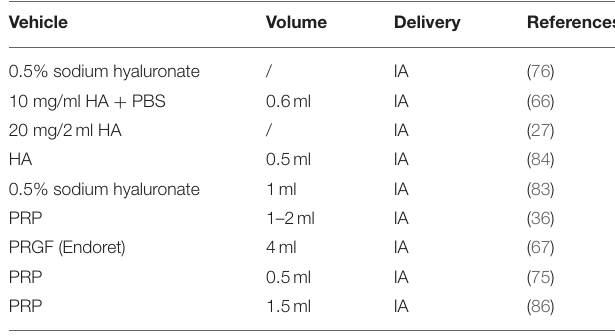
TABLE 5 | Chemical vehicles used for delivery of MSCs in canine OA. TABLE 6 | Biological vehicles used for delivery of MSCs in canine OA.